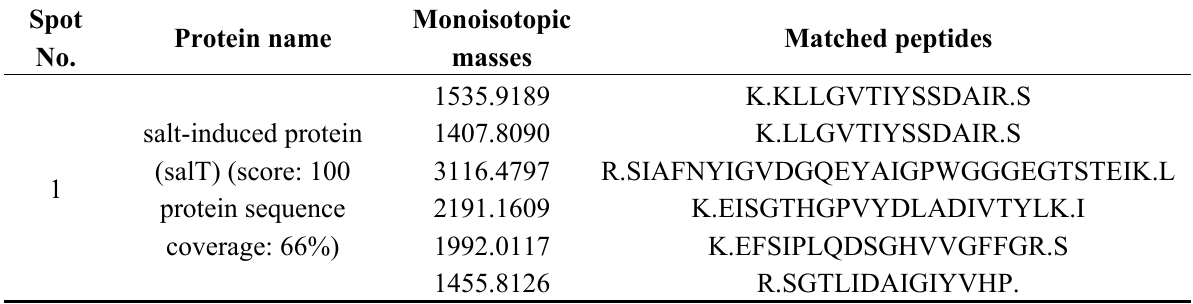
Table 1. Protein identified by MALDI-TOF-MS from Zhefu 802 ( O. sativa L. ssp. indica ).